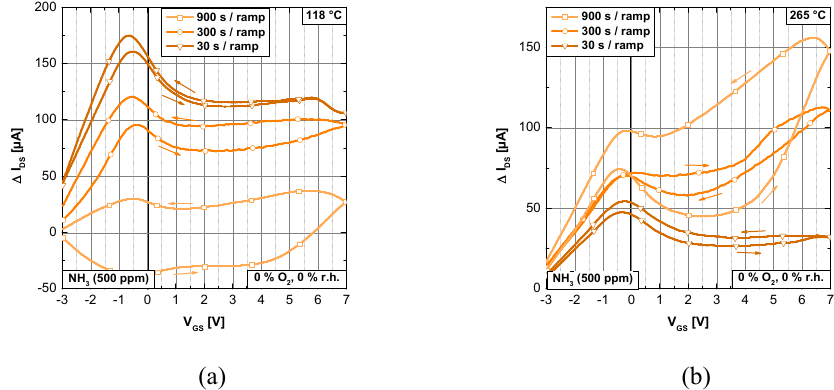
Figure 11. Hysteresis for NH 3 (500 ppm) in dry nitrogen at 118 °C (a) and 265 °C (b) for different ramp durations (rectangle marker 900 s, circle marker 300 s, triangle marker 30 s).